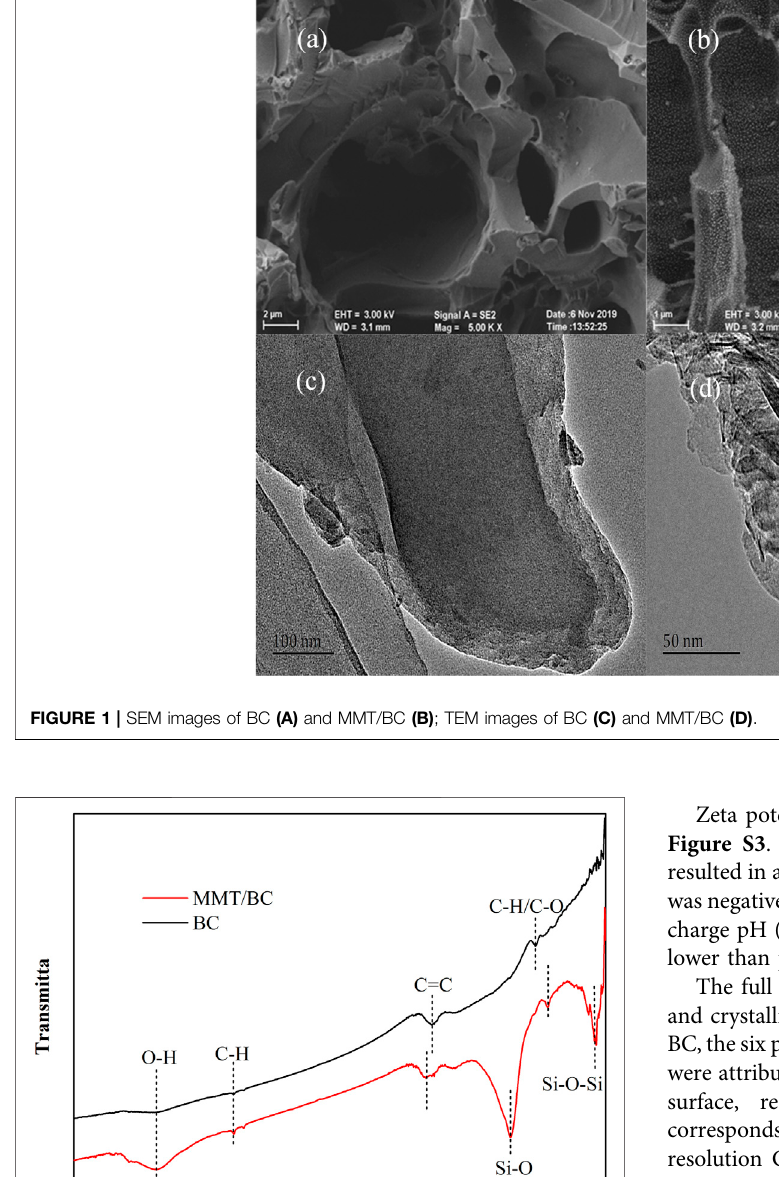
FIGURE 2 | FTIR spectra of BC and